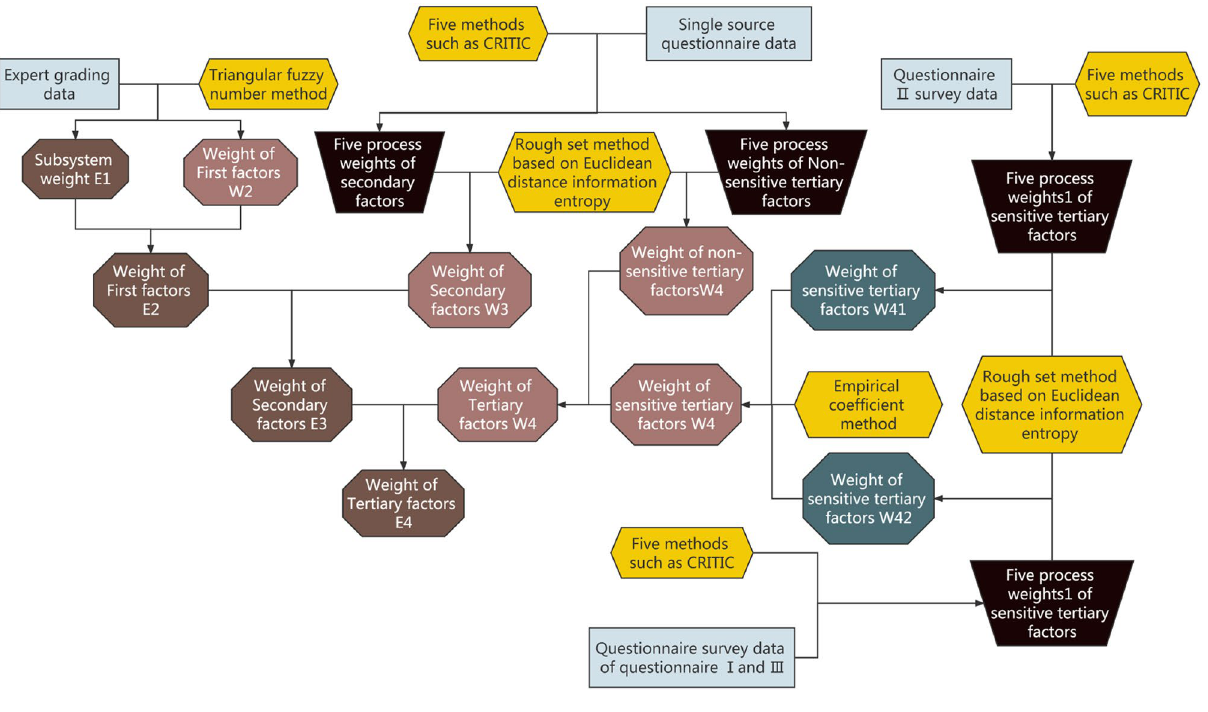
Figure 5. Flow chart of weight calculation.